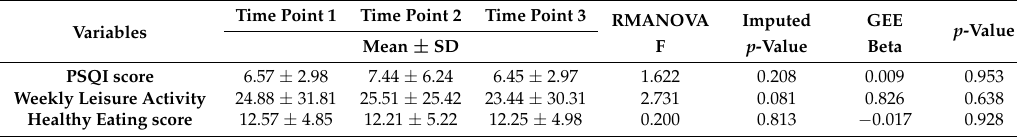
Table 3. A summary of lifestyle measurements in hikikomori followed up for one